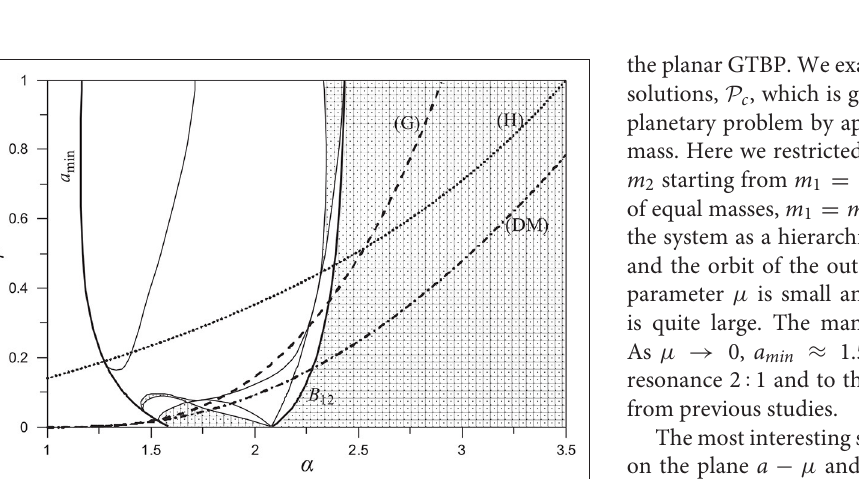
FIGURE 5 | The stability map of the manifold P c of periodic orbits, which is projected on the plane a − µ . The manifold is restricted on the right of the white region and extends to a → ∞ (as a blue region).